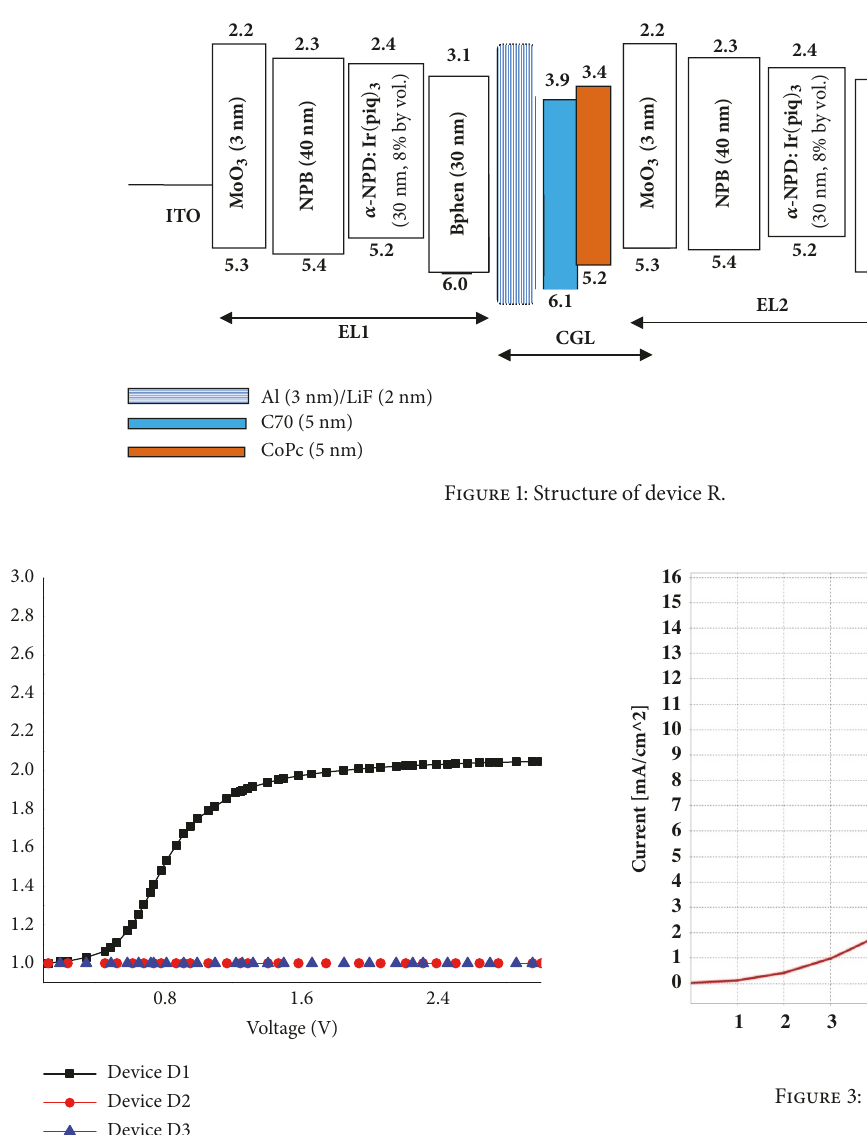
Figure 2: CV characteristics of devices D1, D2, and D3.